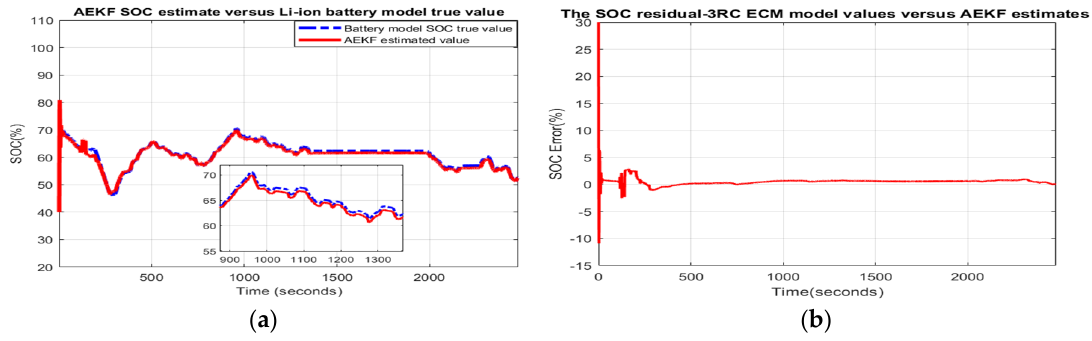
Figure A13. Robustness to changes in SOC initial value—SOCini = 0.4. ( a )AEKF SOC estimate versus battery SOC true value; ( b ) SOC residual.